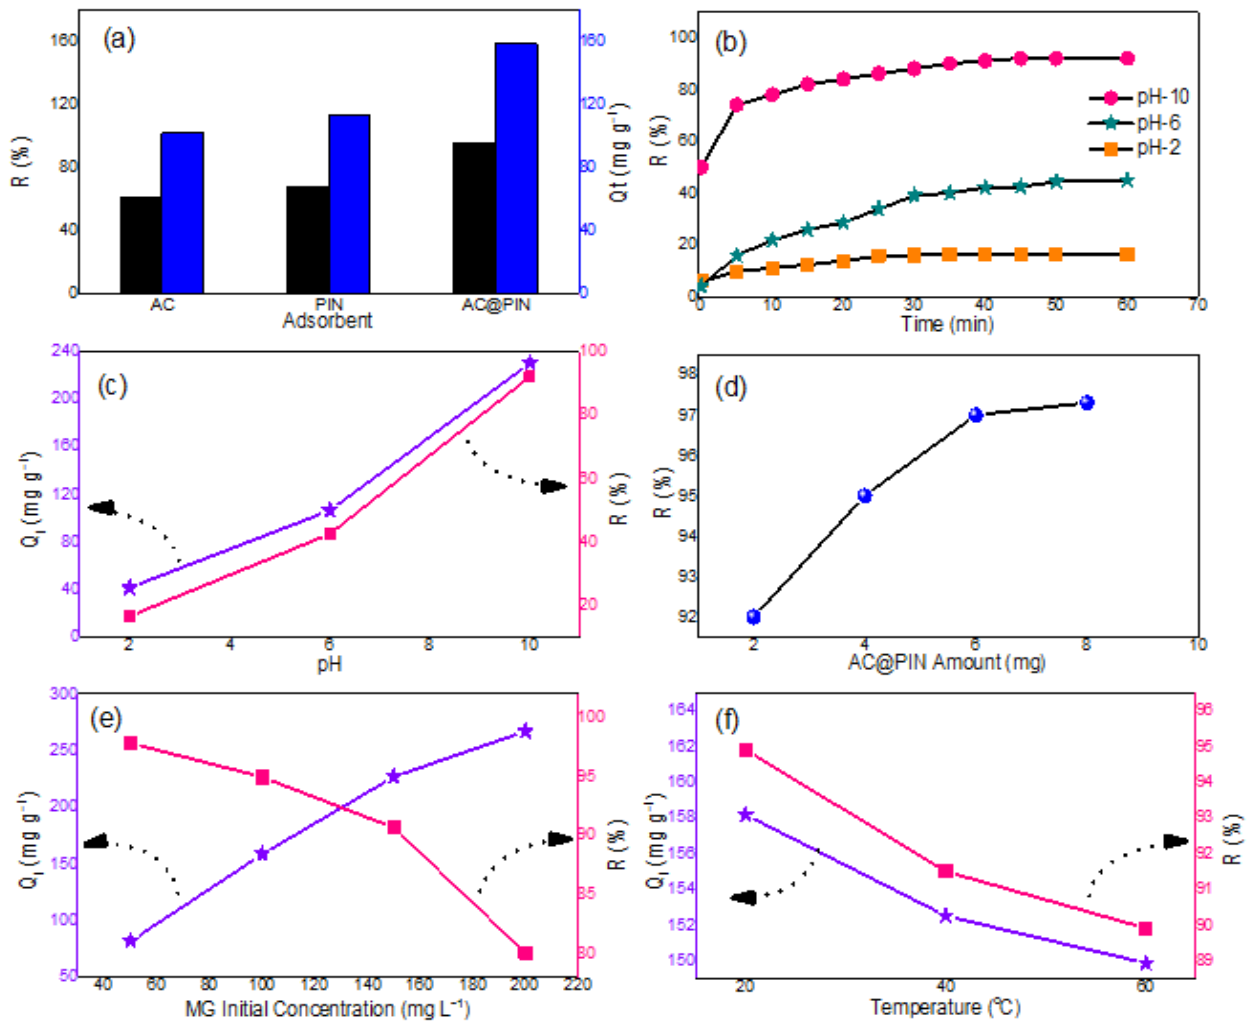
Figure 7. ( a ) Adsorption efficiency and capacity of AC, PIN, and AC@PIN composite, ( b , c ) percent removal of MG as a function of time and pH [Co = 50 mg L − 1 ; Temperature = 20 °C; AC@PIN = 2 mg], ( d ) effect of AC@PIN amount on adsorption of MG [Co = 50 mg L − 1 ; Temperature = 20 °C; pH = 10; contact time = 60 min], ( e ) effect of initial concentration on MG adsorption [Temperature = 20 °C; pH = 10; contact time = 60 min; AC@PIN = 6 mg], and ( f ) effect of temperature on adsorption of MG [Co = 100 mg L − 1 ; pH = 10; contact time = 60 min; AC@PIN = 6 mg].